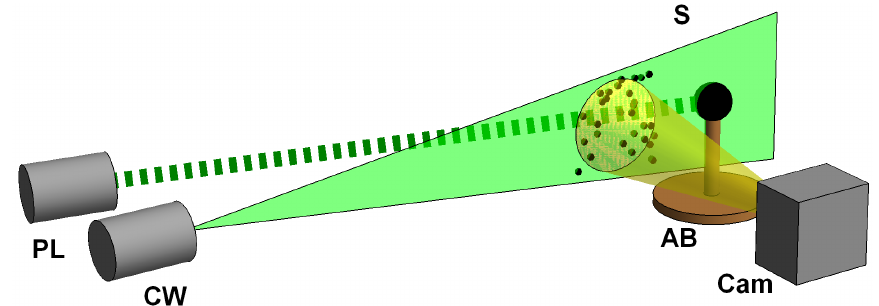
Figure 1. Scheme of the experimental setup including the nanosecond pulsed laser (PL), CW-laser (CW), analytic balances platform (AB), high-speed camera (Cam), sample of the fuel